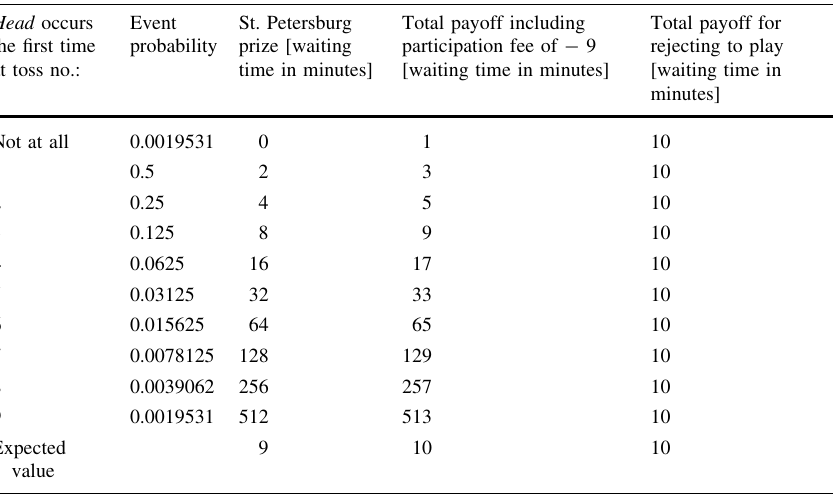
Table 3 St. Petersburg lotteries for waiting time ( n = 9, base time 10 min) Head occurs Event St. Petersburg the first time probability prize at toss no.: